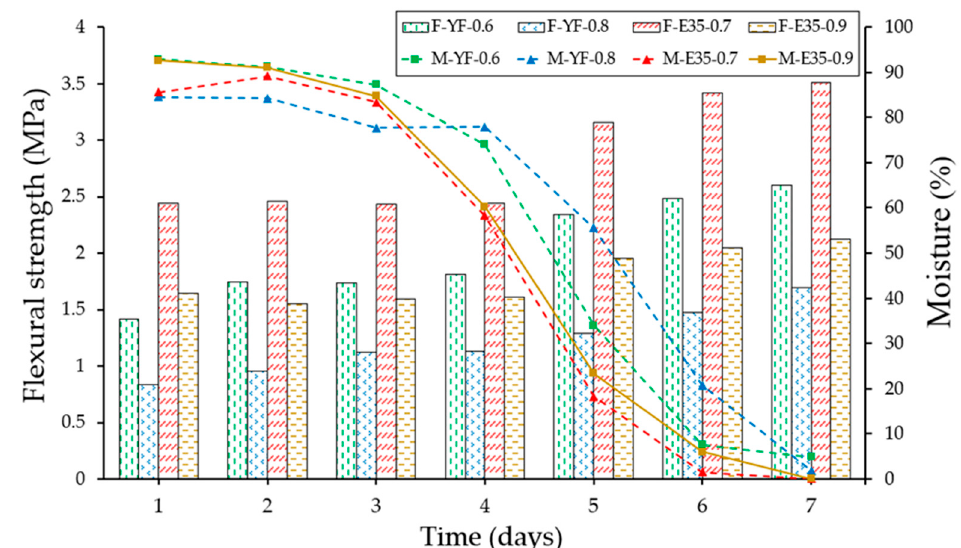
Figure 15. Evolution of flexural strength (F) and moisture content (M) of the different specimens over time.